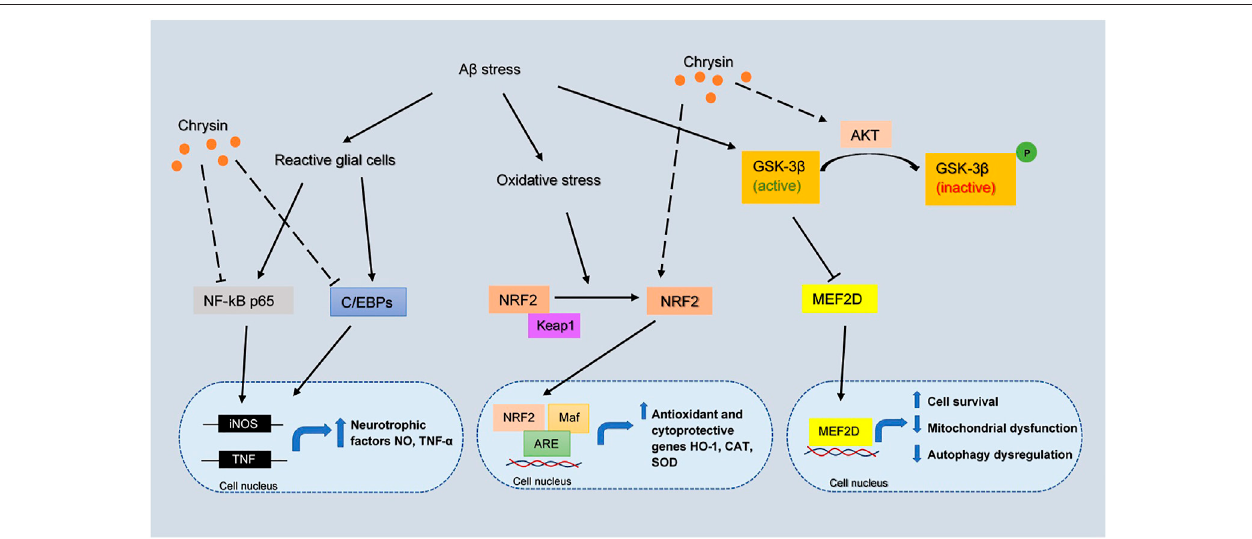
FIGURE 5 | The inferred mechanism of chrysin in AD pathology. The drug acts through inhibition of NF-kB p65, C/EBPs and activation of NRF2, AKT pathway. The inhibition ofNF-kB p65 and C/EBPsleads todecreased transcription ofiNOSand TNF geneswhich contributes tothe productionofneurotrophicfactors.The activationof NRF2 leads to the binding with Maf and ARE which increases the transcription of antioxidant and cytoprotective genes HO-1, CAT, and SOD. The strengthening of AKT pathwaypreventsthedeactivationofMEF2DbyGSK3 β ,whereMEF2Disakeyregulatorforcellsurvival,mitochondrialdysfunctionandautophagydysregulation.The solid lines show the interactions of protein kinases and translocation into the nucleus. The long-dashed lines show the pharmacological action of the drug.